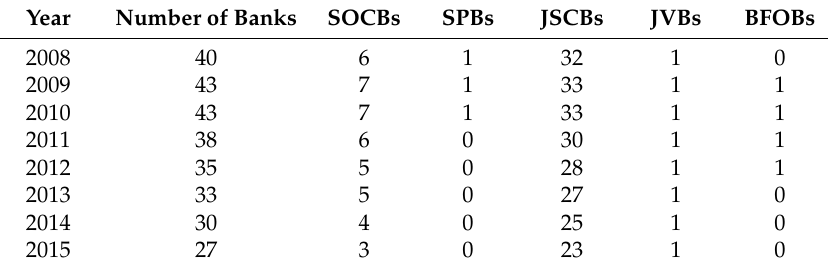
Table 1. Number of banks tested every year during the period 2008–2015.